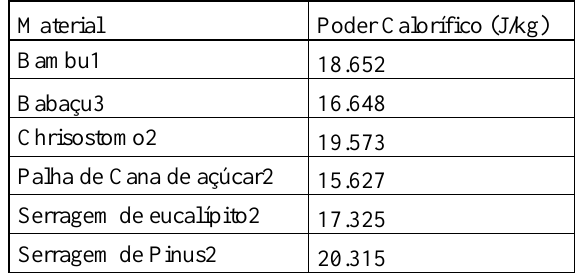
Tabela 3: Comparação briquete babaçu e briquetes de